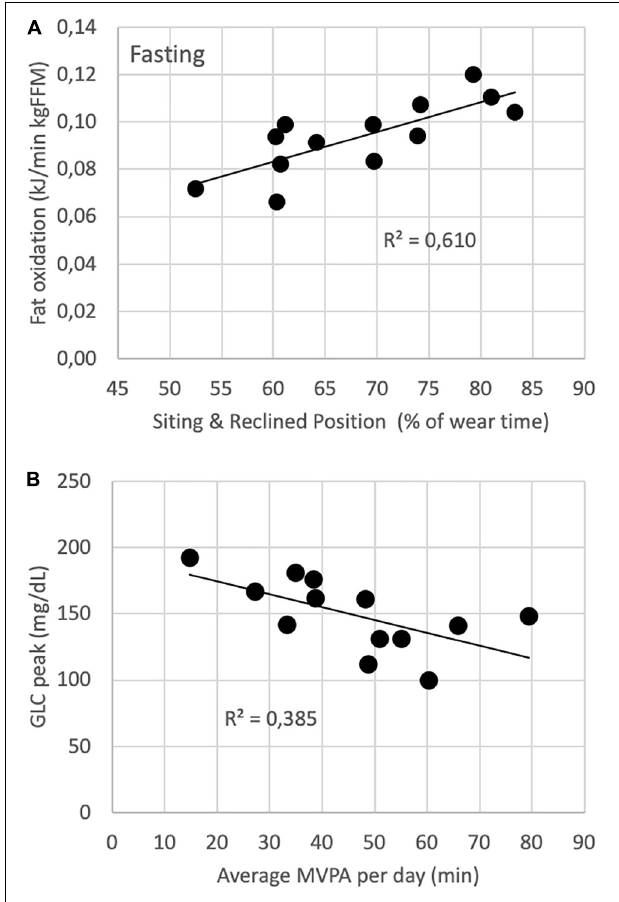
FIGURE 1 | The relationship between sitting/lying time and fat contribution to energy metabolism per unit FFM (A) , and between average time of daily MVPA and peak capillary blood glucose level in response to a test meal (B)